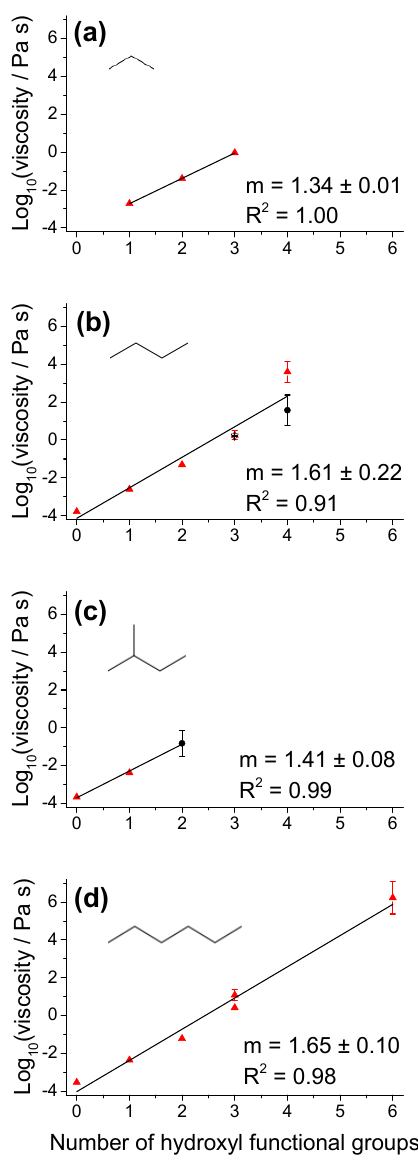
Figure 3. Plot of log 10 (viscosity/Pas) vs. the number of hydroxyl (OH) functional groups for compounds with (a) linear C 3 , (b) lin- ear C 4 , (c) branched C 5 , and (d) linear C 6 carbon backbones. Ex- perimental values determined here are shown in black, with the upward-pointing triangle corresponding to measurements using a rotational rheometer, and error bars corresponding to ± 5%, and cir- cles corresponding to measurements using the bead mobility tech- nique, with error bars corresponding to an uncertainty of 2 σ . Lit- erature values (Czechowski et al., 2003; Haynes, 2015; Viswanath et al., 2007; Sheely, 1932; Sigma-Aldrich, 1996; Song et al., 2016; Jarosiewicz et al., 2004) are shown in red. Solid lines shown on each plot are a linear fit on each of the plots with the corresponding val- ues for the slope ( m ) and the coefficient of determination ( R 2 ), with standard error being used to determine the uncertainty in the gradi- ent. The structures of the relevant carbon backbones are included in the top left corner of each panel.